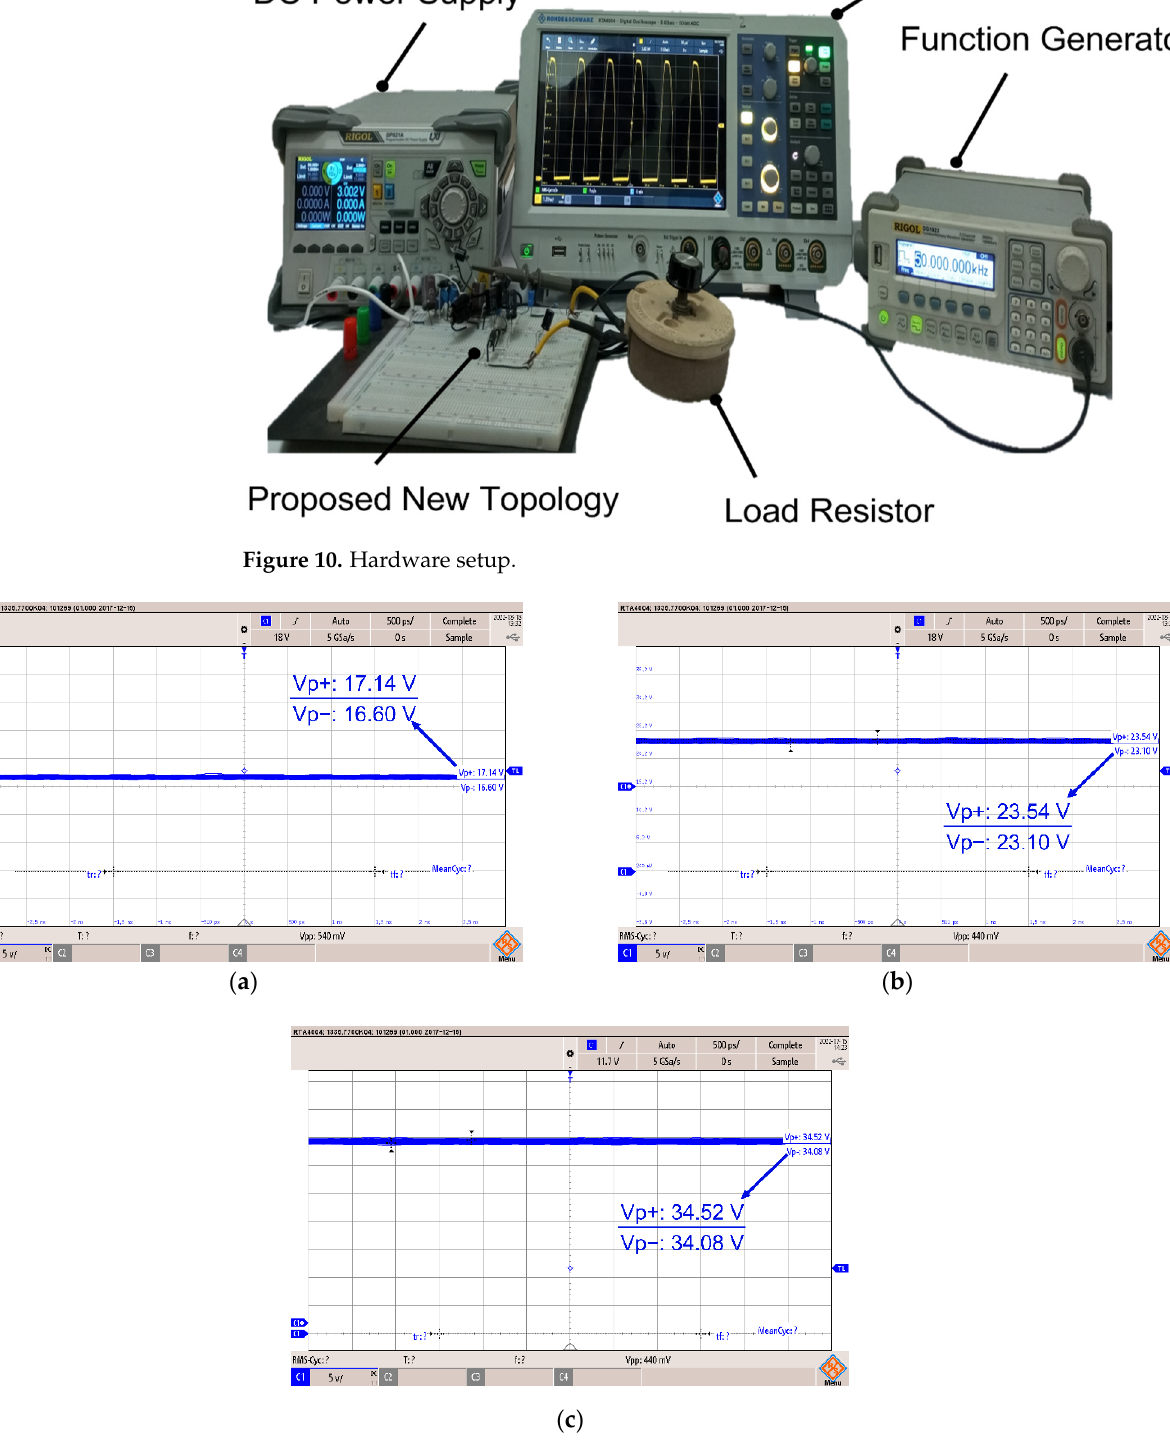
Figure 11. Output voltage across load resistor at V in = 3 V and ( a ) D = 0.3, ( b ) D = 0.4, and ( c ) D = 0.5.